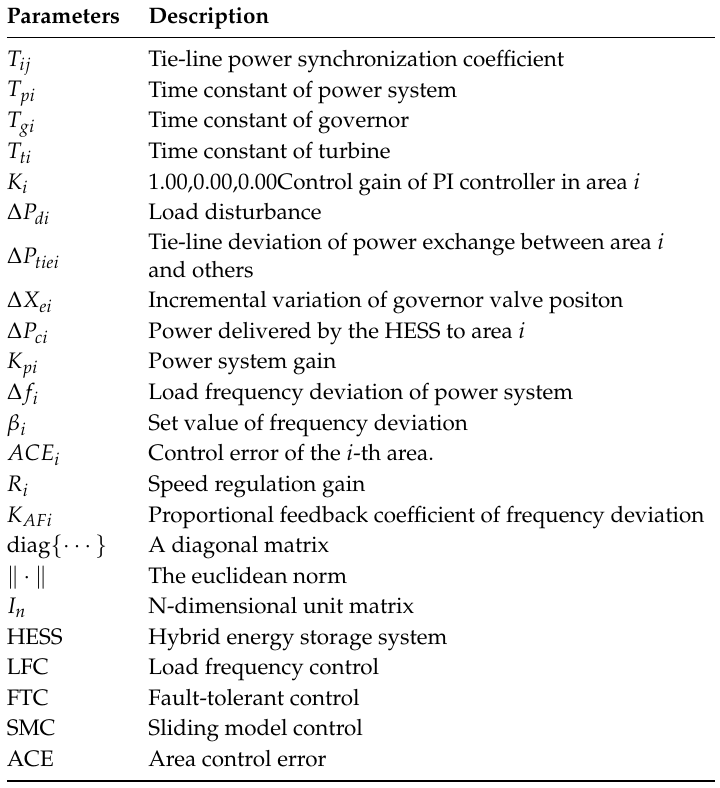
Table 1. Nomenclature used in the paper.